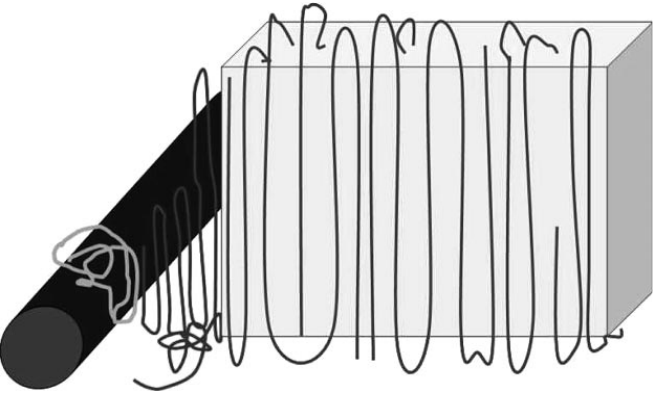
Figure 22. Sketch explaining the possible nucleation mechanism of iPP on the surface of a CNTs; iPP macromolecules initially are partly wrapped around the CNTs (brighter macromolecule in the sketch, dark rod represents a CNTs) and form a nuclei with crystallographic c -axis perpendicular to the long axis of the CNTs. Reproduced with permission from ref.